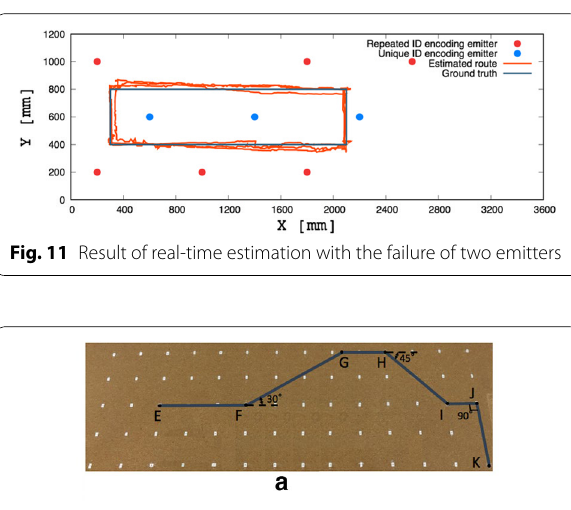
Fig. 12a. The robot started from point E with the ori- entation of 0°. During the movement, the orientation of the robot changed to 30°, 45°, and 90° at points F, H, and J, respectively. This approach to evaluating the validity of the positioning system by altering the ori- entation of the mobile robot during its movement is